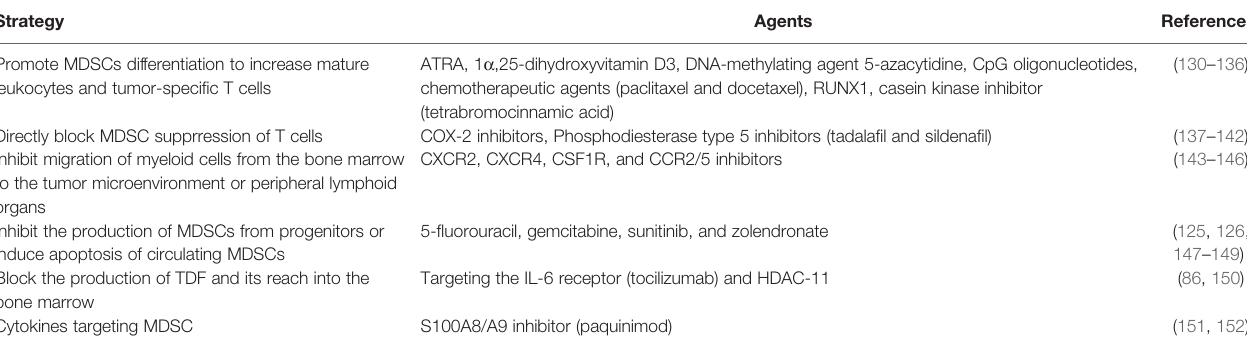
TABLE 3 | Potential therapeutic candidates for targeting MDSCs.